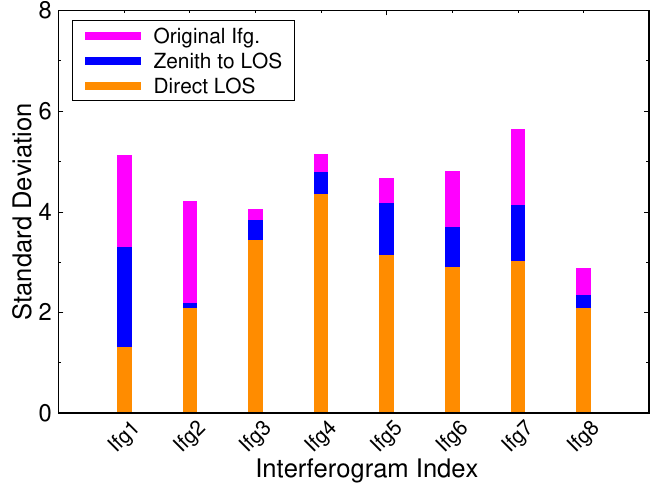
Figure 12. SD comparison of original interferograms (magenta bars), residual phases corrected from Z-LOS method (blue bars), and residual phases after D-LOS correction (orange bars) on all eight pairs in